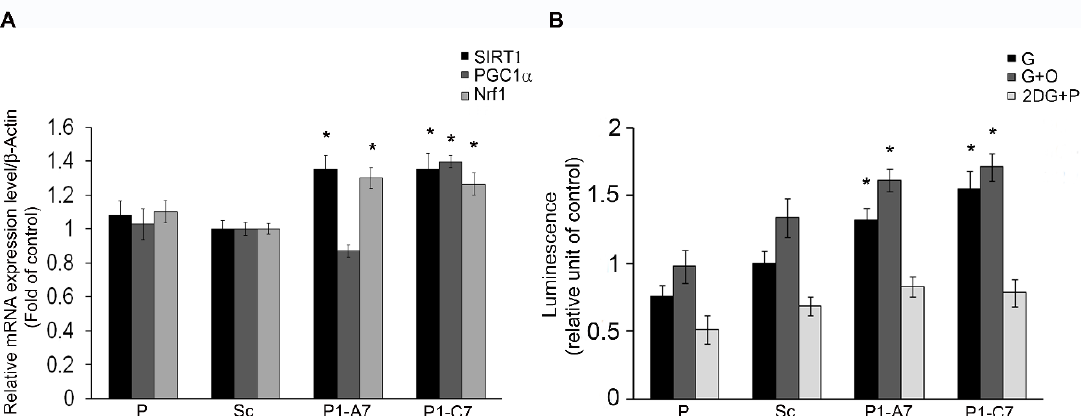
Figure 2. Effects of Pin1 silencing on cell energy metabolism. ( A ) mRNA expression levels of SIRT 1, PGC 1a and NRF 1. ( B ) To measure the total ATP content, cells were incubated for 2 h with either 10 mM D -glucose (G), 10 mM D -glucose plus 2.5µg/mL oligomycin (G + O), or 50 mM 2-deoxy-D-glucose plus 5 mM sodium pyruvate (D + P). Results are expressed as mean values ± SD. * p < 0.05 vs. Scramble clone.